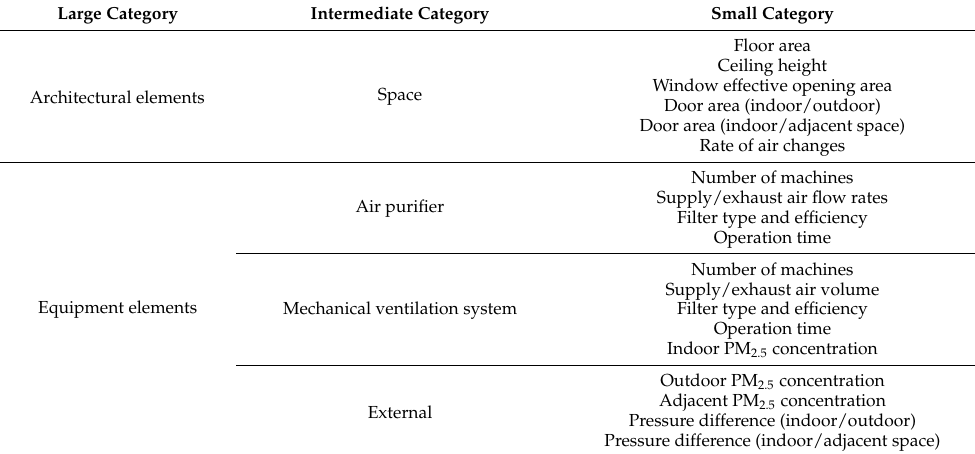
Table 3. Category selection according to the classification of factors affecting changes in PM 2.5 concentration.